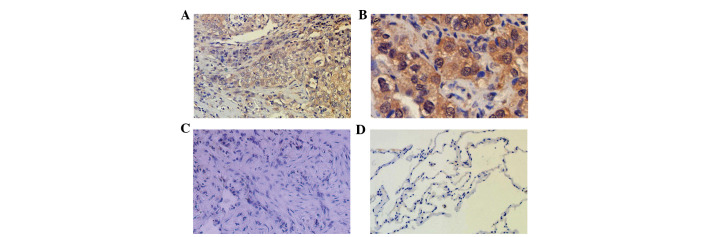
Notch3 expression in subtypes of cancerous tissue and corresponding non-tumor tissue (IHC, ×200). (A) Lung squamous cell carcinoma: Positive staining is evident in the cytoplasm and nucleus. (B) Lung adenocarcinoma: Stronger positive staining is visible in the cytoplasm and nucleus. (C) Small cell lung cancer: Positive staining is not evident in the cancer cells. (D) Non-tumor tissue. Positive staining is shown in the small vessels and weaker staining is observed in the alveolar epithelial cells in non-tumor tissues.